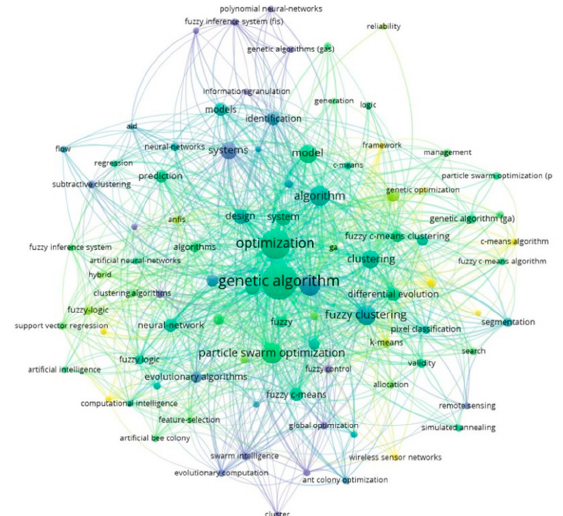
Figure 5. Total cluster obtained with the search “optimization fuzzy clustering with genetic algorithms” from VOSviewer. Algorithms 2021 , 14 , x FOR PEER REVIEW Figure 6, represents the selection of the keyword “genetic algorithm” that cor- responds to the information obtained from Figure 5.